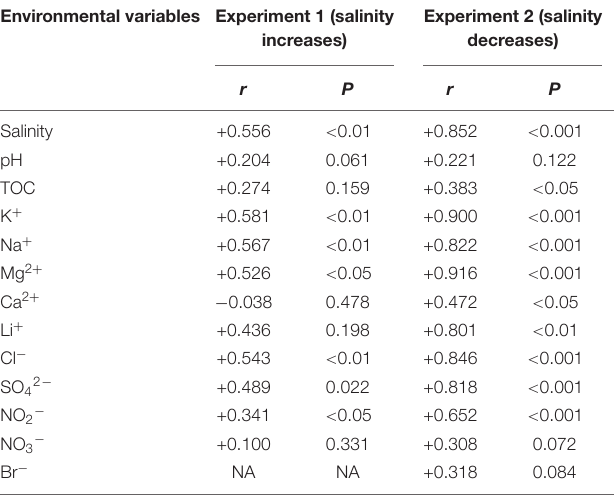
TABLE 2 | Mantel test showing Spearman’s correlation (r) between the microbial community structures and environmental variables of the transplanted sediments (permutation: 9999).